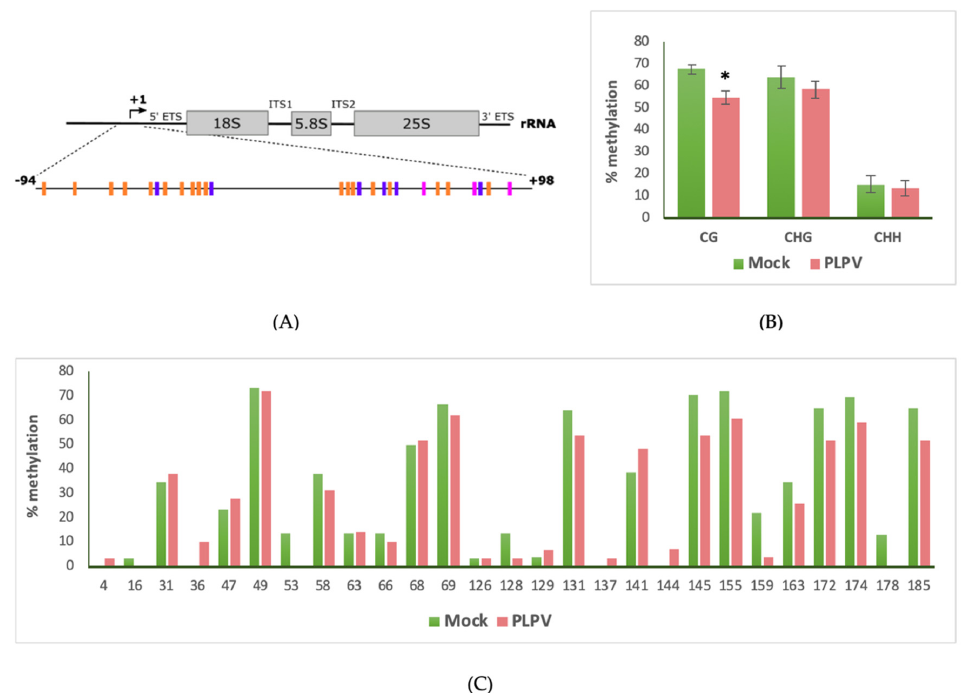
Figure1. PLPVinfectioninduceschangesinthemethylationpatternofrDNApromoterin N.benthamiana . ( A ) Diagram of the 45S rRNA transcriptional unit with the transcription start site indicated by an arrow. Stretch selected for analysis by bisulfite sequencing is detailed at the bottom, with the potential methylated cytosines labelled in pink (CG), purple (CHG), and orange (CHH). ( B ) Di ff erential DNA methylation levels between mock-inoculated (green) and PLPV-infected plants (red) in the CG, CHG, and CHH sequence contexts. Error bars depict the standard deviations from two independent biological replicates and the statistical significance was tested using a paired t -test (* p < 0.05). ( C ) Position-specific methylation levels in the analyzed samples of